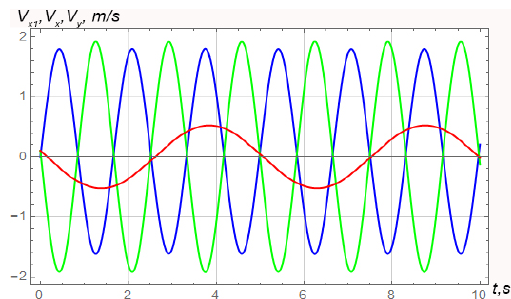
Figure 6. Phase trajectory θ - (cid:5) θ